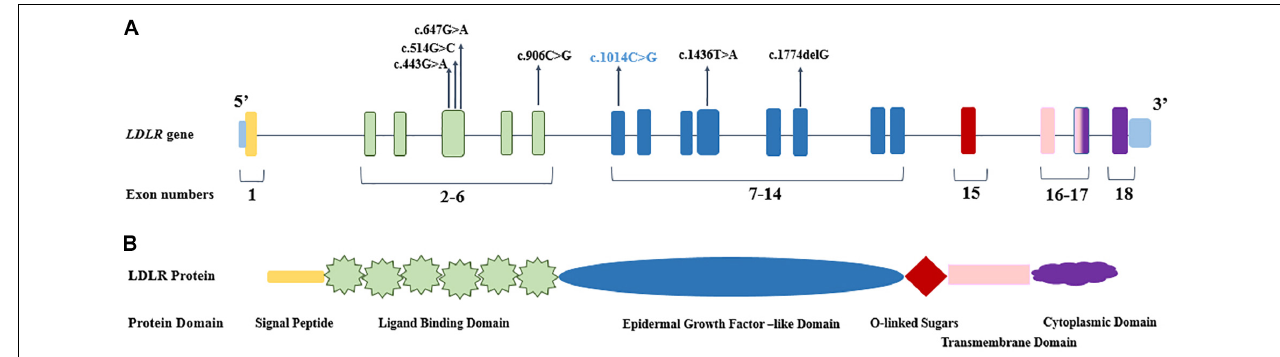
FIGURE 1 | The genomic and protein organization of LDLR. (A) The location of identified pathogenic mutations demonstrated in the different exons of LDLR gene. The novel mutation presented in blue color. (B) The domain organization of LDLR protein, which corresponded to LDLR coding exons (with the common colors).